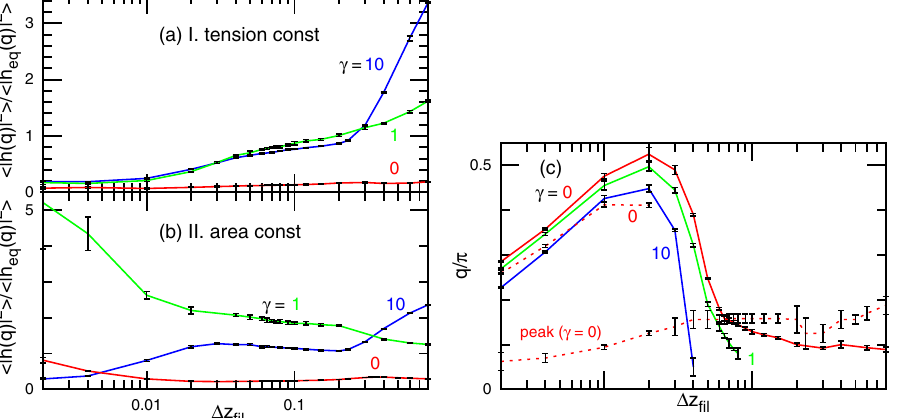
Figure 5. Dependence of the spectrum shape on (cid:31) z fil . ( a , b ) Normalized undulation amplitude 2 2 / h ( q ) h eq ( q ) at the lowest wave-number q �| | � �| | � II (area constraint). ( c ) The upper four lines represent the wave-number q at solid lines represent the data at γ lines represent the data at γ